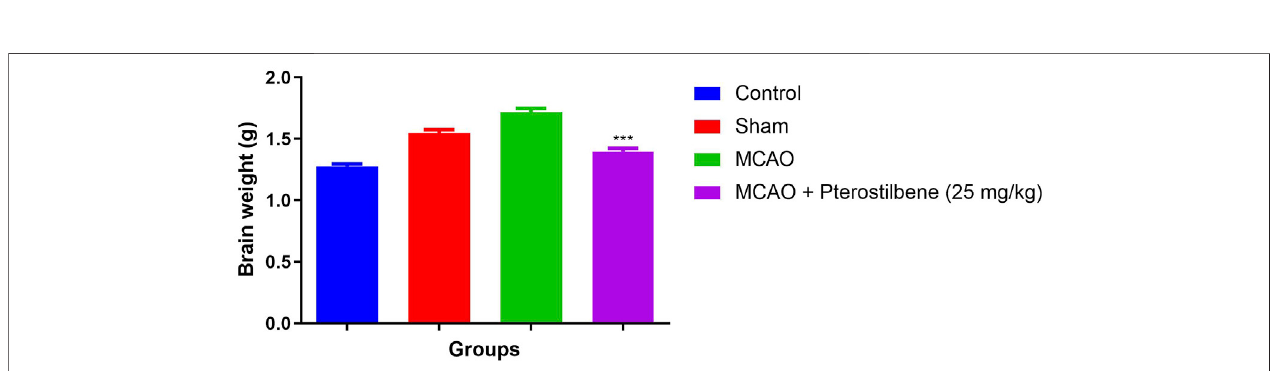
FIGURE 3 | showed the brain weight of among experimental groups. Values are expressed as mean ± SEM. The t -test was used for the signi fi cant difference between groups: * p < 0.05, ** p < 0.01, *** p < 0.005. NS, non-signi fi cant.